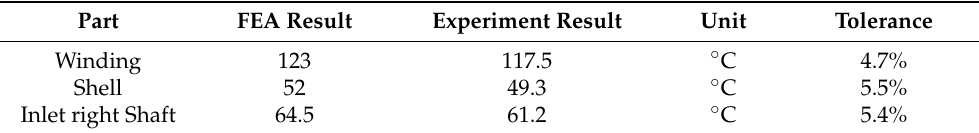
Figure 30. Infrared thermometer to measure shell and shaft. Table 7. Temperature results of HSPMSM between experiment and FEA